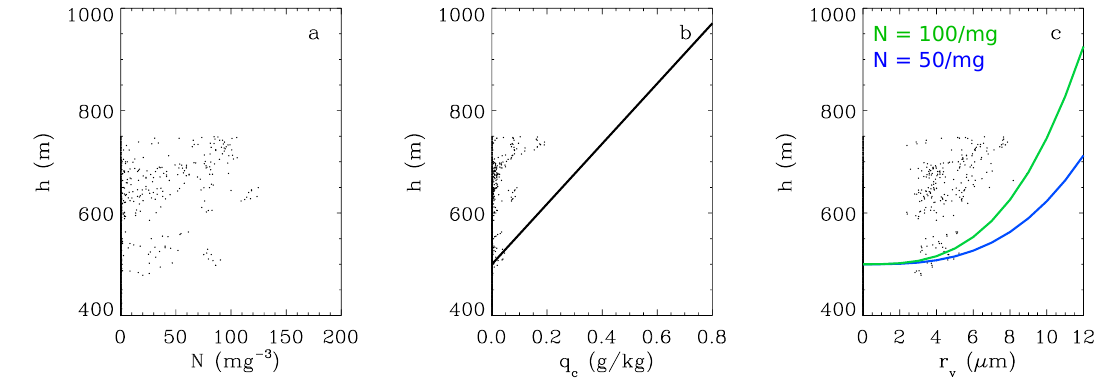
Fig. 4. As Fig. 3 but for the cumulus cloud layer. Vertical axes represent height above the sea level.